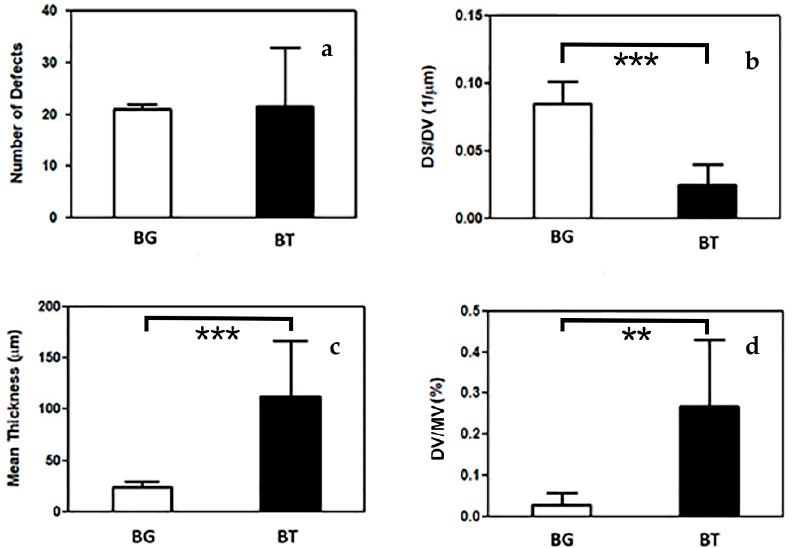
Figure 2. Results obtained by the Defect Analysis Tool, which compared BG and BT groups. As resulting from Table 2, ( a – d ) show the number of defects ( a ), DS/DV ( b ), mean thickness ( c )